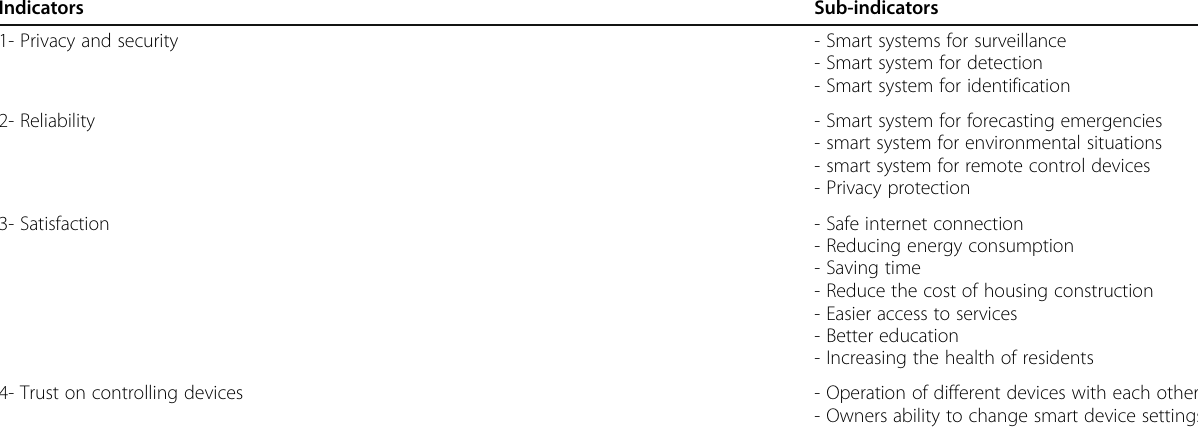
Table 8 Components and sub-components of the social problems in the smart home Indicators